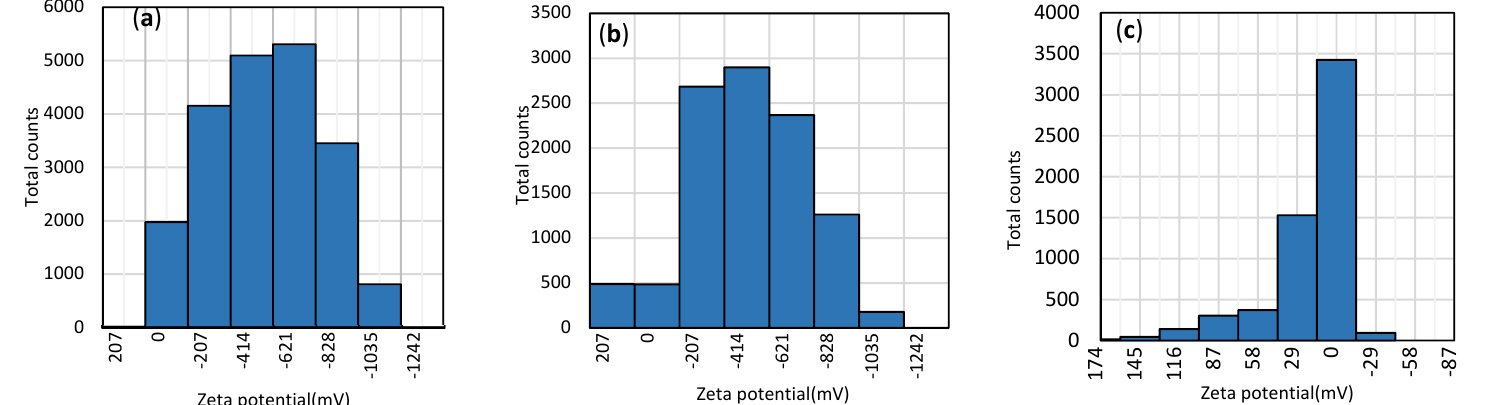
Figure 2. ( a ) Dispersion results of 0.006 g CNTs in 80% ethanol solution, ( b ) Dispersion results of 0.006g CNTs in 0.1 mol/L SDBS ethanol solution and ( c ) Dispersion results of 0.006 g CNTs in 2% SDBS aqueous solution.